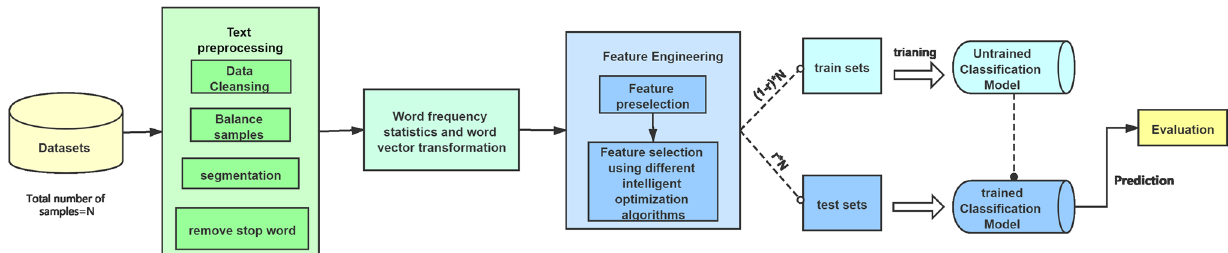
Fig. 11 General framework of Chinese text classification task